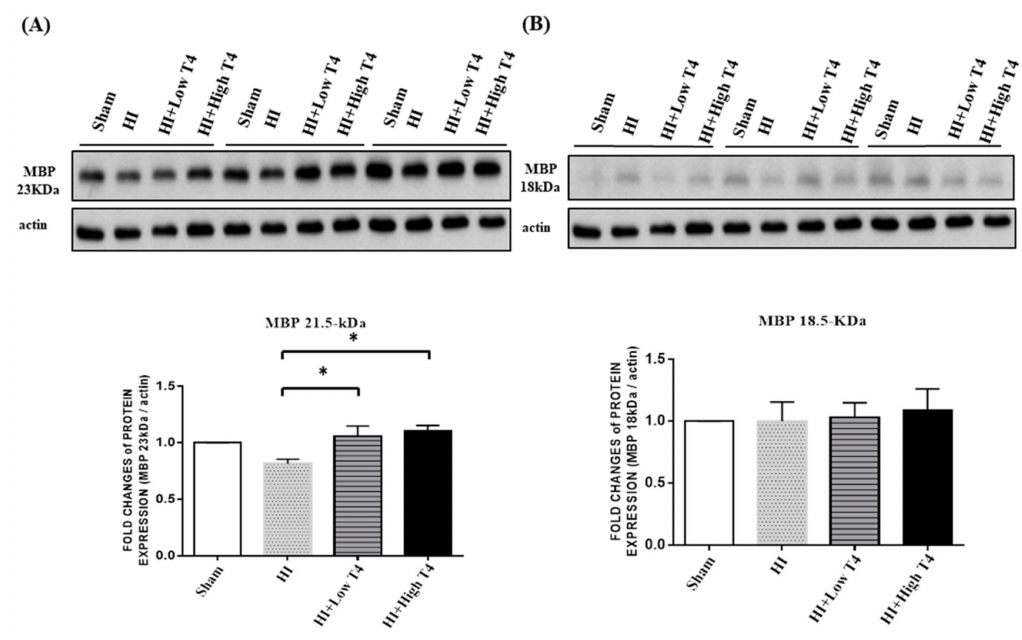
Figure 2. Immunoblots of MBP isoforms in injured WM. ( A ) Both low and high doses of T4 increased the levels of the 21.5 kDa isoform. ( B ) Neither dose of T4 had an effect on the levels of the 18.5 kDa isoform. * p < 0.05.